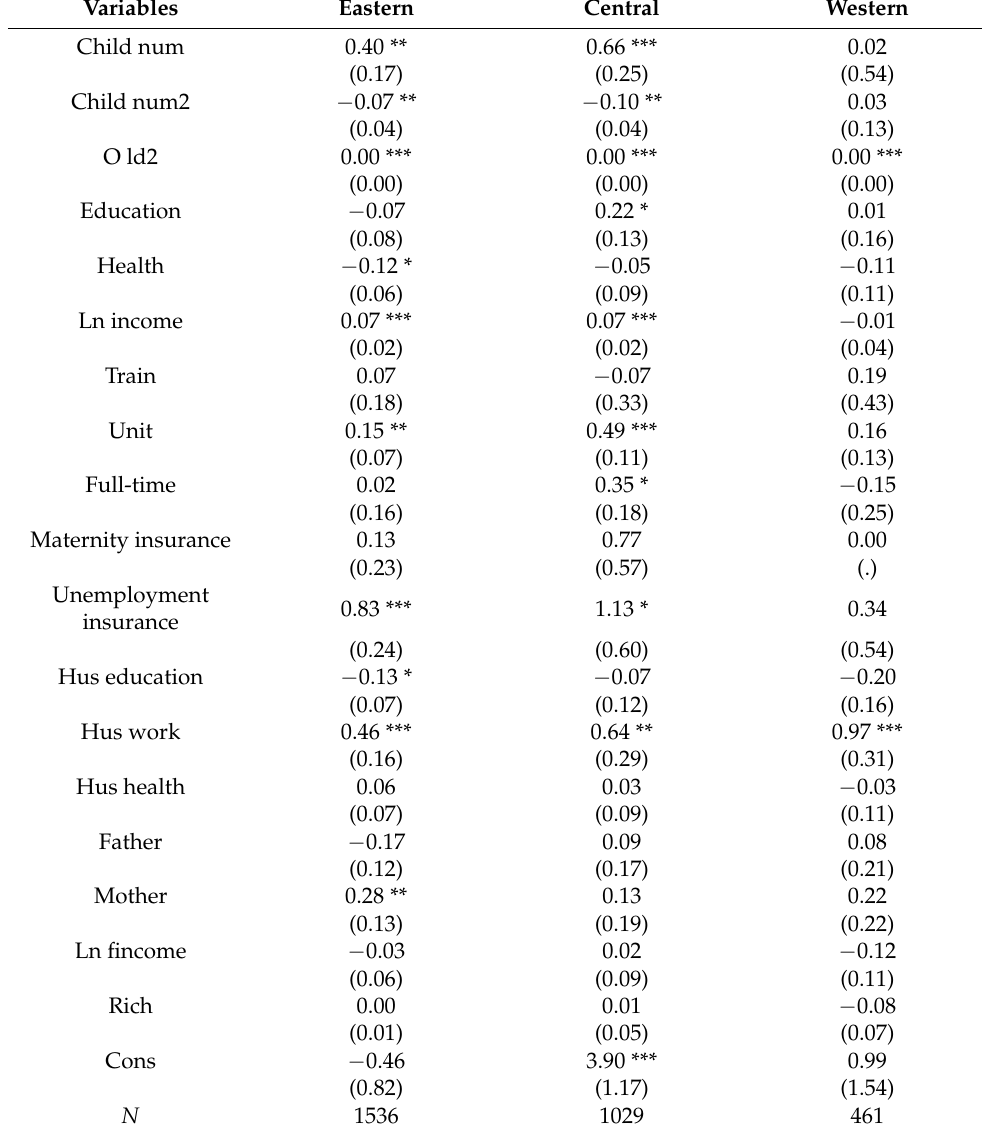
Table 8. Heterogeneity test: regional heterogeneity. Variables Eastern